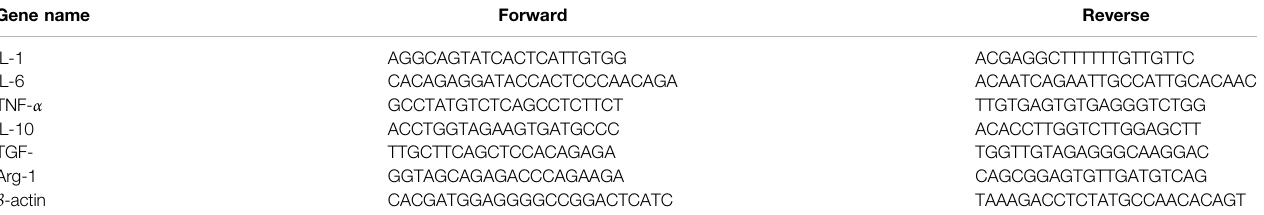
TABLE 4 | Primer sequence of target genes (All genes species are mouse).